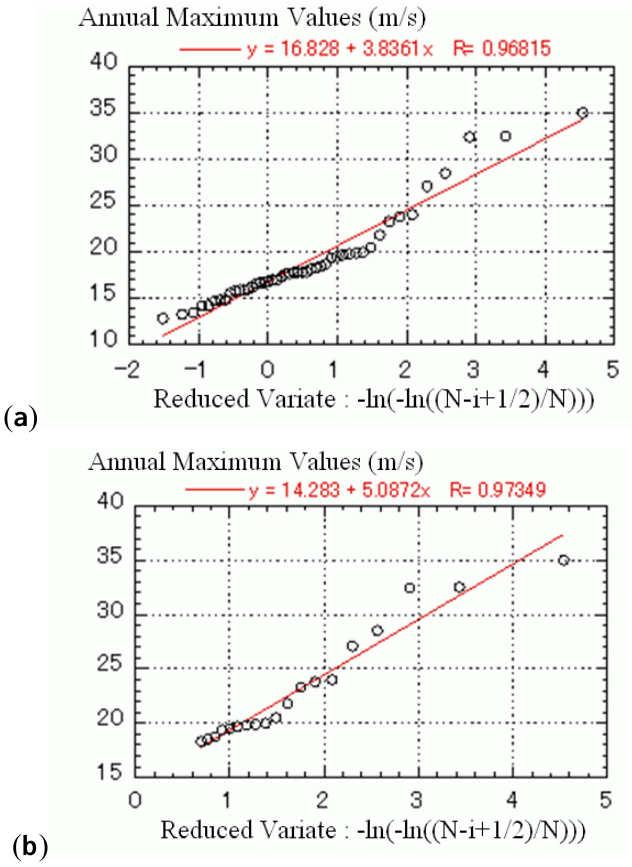
Figure 6. Relationship between the annual maximum values of the 10-minute average wind speed data collected at the Wakayama Meteorological Observatory and the reduced variate of the Gumbel analysis. ( a ) For the entire range of wind speeds (= 47 data values);